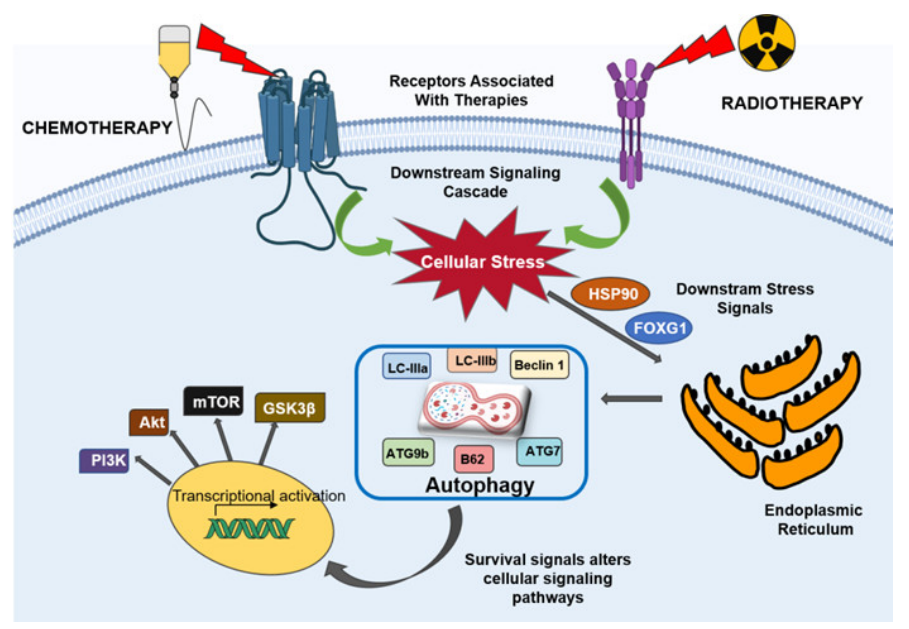
Figure 3. The underlying molecular mechanism of autophagy-mediated therapeutic resistance in glioblastoma.